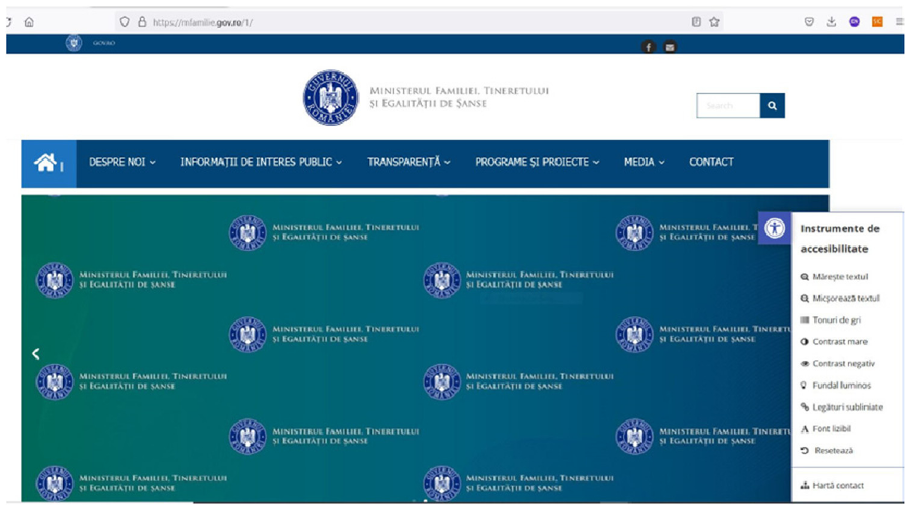
Figure 2: Ministerul Familiei, Tineretului ș i Egalit ă ț ii de Ș anse [ Ministry of Family, Youth and Equal Opportunities ] website.